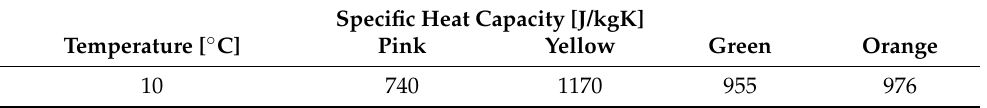
Table 5. The measured specific heat capacities.